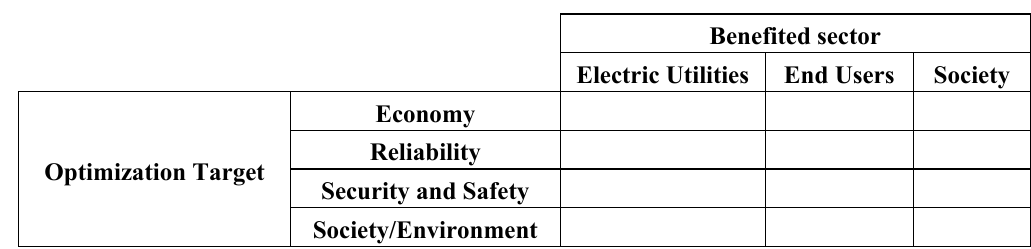
Figure 3. Mapping of optimization targets to benefited